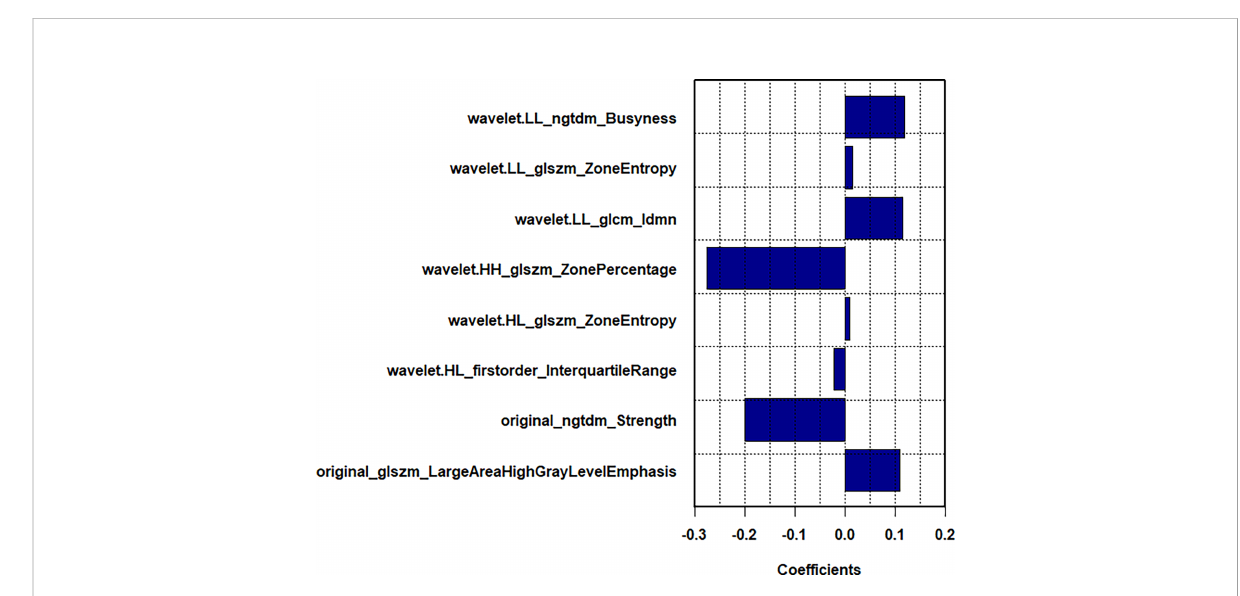
FIGURE 3 In LASSO regression, a coef fi cient pro fi le plot was drawn and resulted in 8 radiomic features with nonzero coef fi cients.